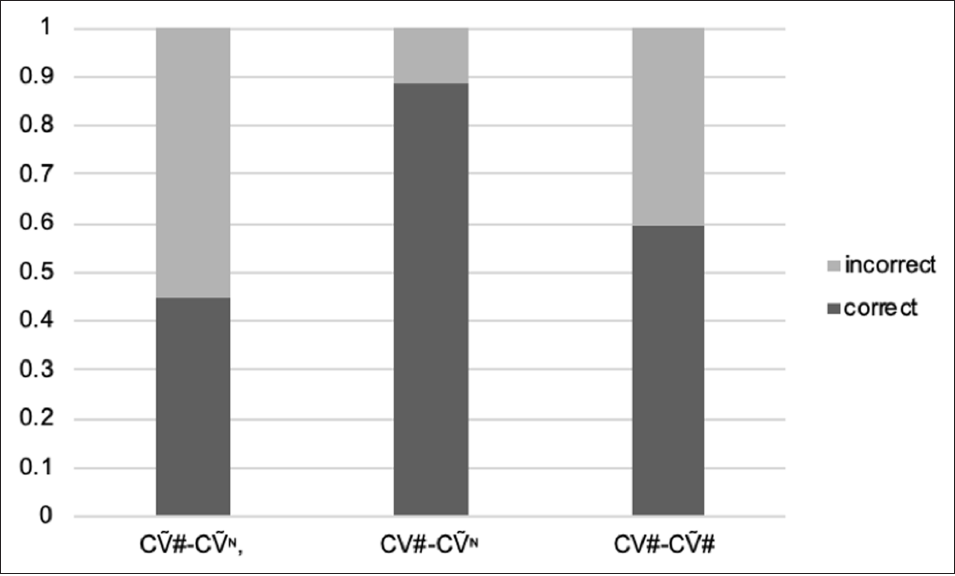
Figure 3: Overall accuracy by stimulus pair